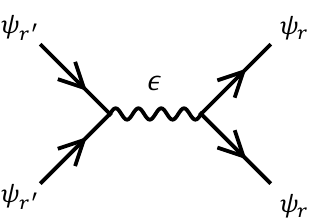
Figure 5 . The process of scrambling that conducts by the reparametrization mode that is denoted by (cid:15)